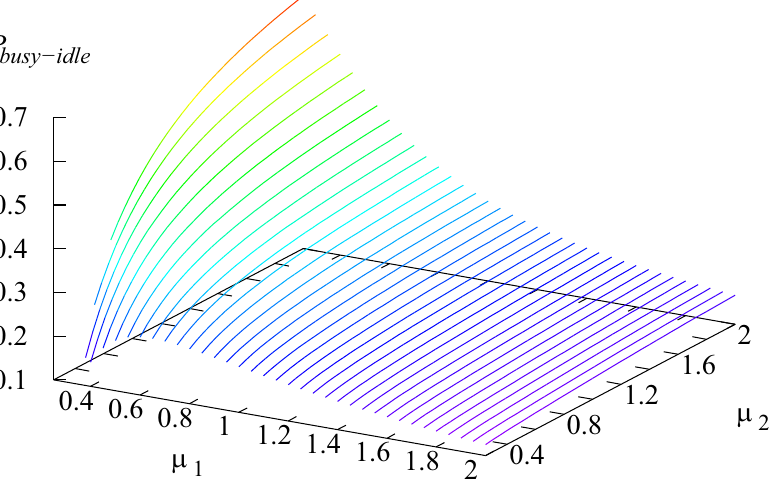
Figure 19. Dependence of the probability P busy − idle that the main server is busy while the secondary server is idle on the parameters µ 1 and µ 2